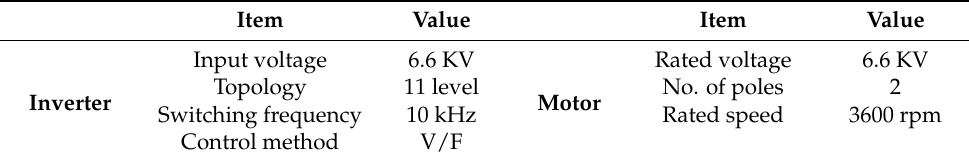
Table 2. Specifications of electric motor drive system (EMDS).